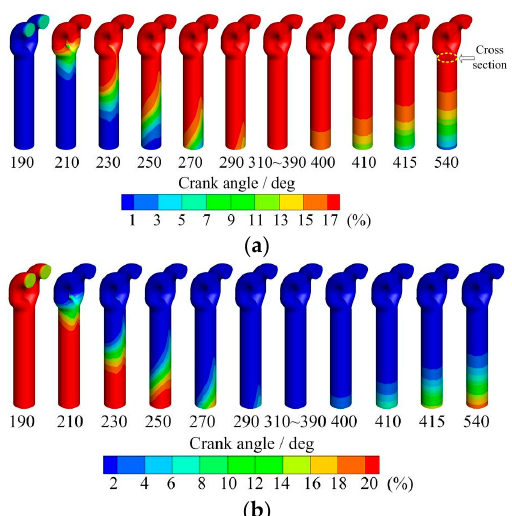
Figure 11. Mass fraction of carbon dioxide and oxygen in 3D simulation: ( a ) Mass fraction of carbon dioxide; ( b ) Mass fraction of oxygen.